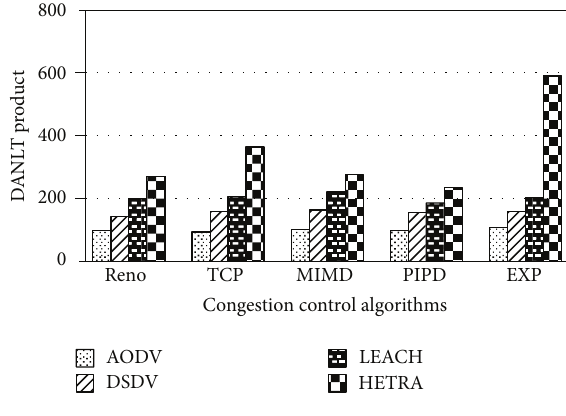
Figure 14: DANLT product for Pattern 7.